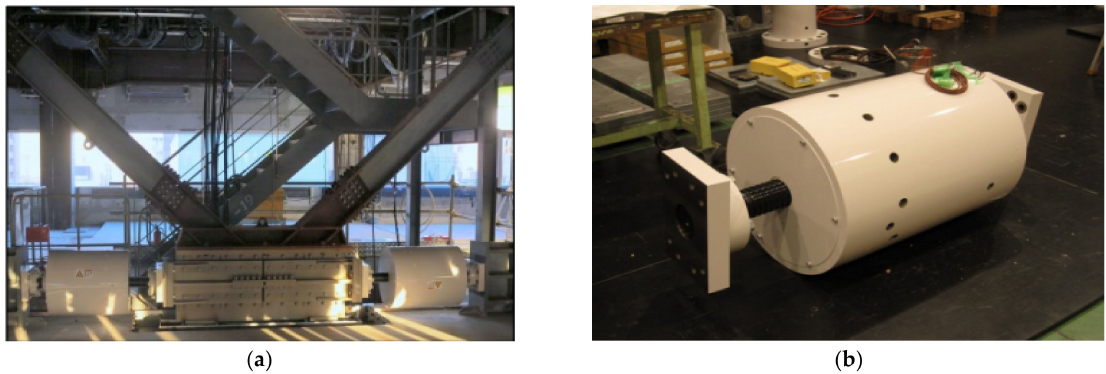
Figure 6. ( a ) Tuned viscous mass damper coupled to a chevron bracing equipping a building in Sendai, Japan; ( b ) tuned viscous mass damper